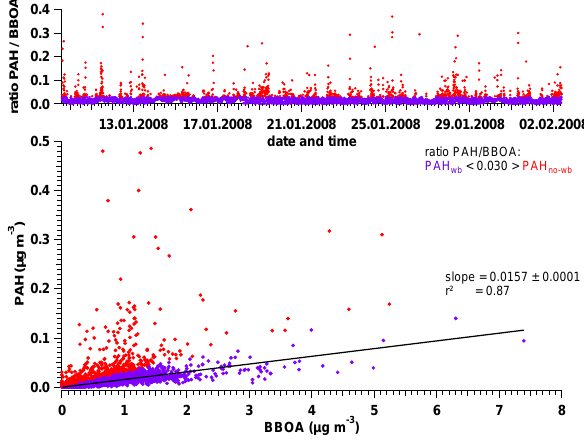
Fig. 8. Estimation of the biomass burning contribution to total PAH concentration. The upper panel represents the time series of the ra- tio PAH/BBOA and the bottom panel shows the correlation between PAH and BBOA. Colors correspond to the differentiation between PAH correlated to wood combustion (purple) and not correlated to wood combustion